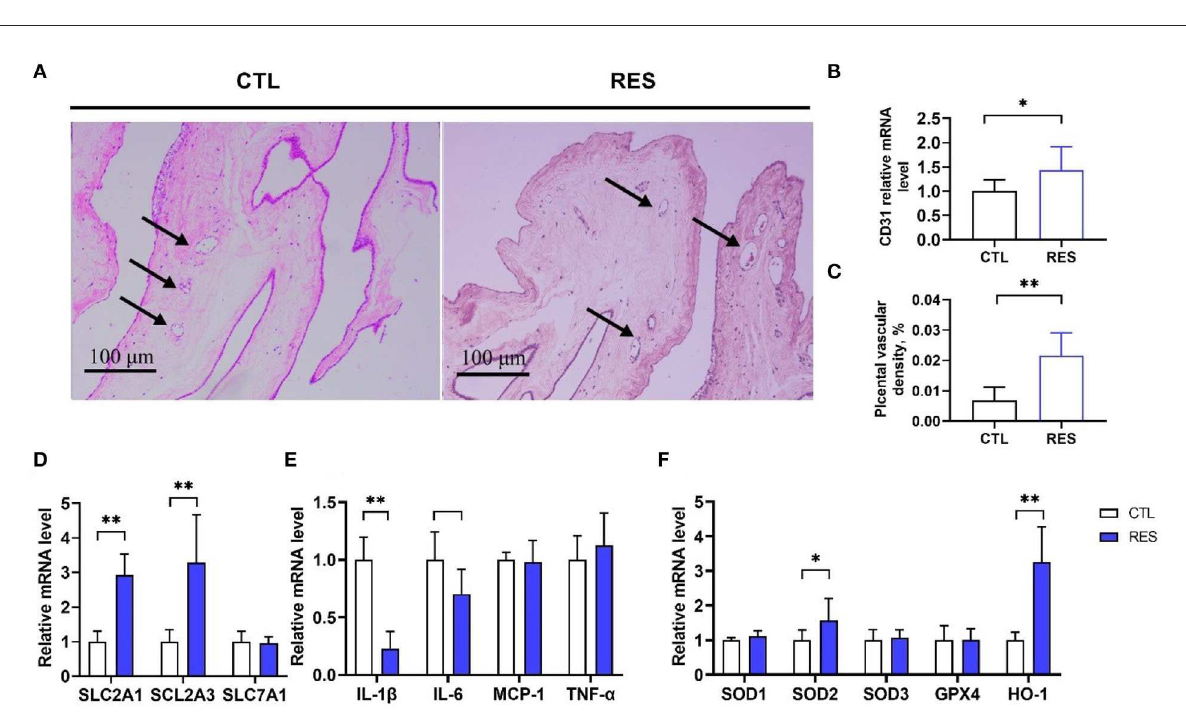
group had a negative linear correlation with SOD2 and HO-1 ( p < 0.05) (Figure 6C). In addition, the Christensenellaceae R-7 group and Ruminococcaceae UCG-005 had a negative linear correlation with SLC2A1 and SCL2A3 ( p < 0.05) (Figure